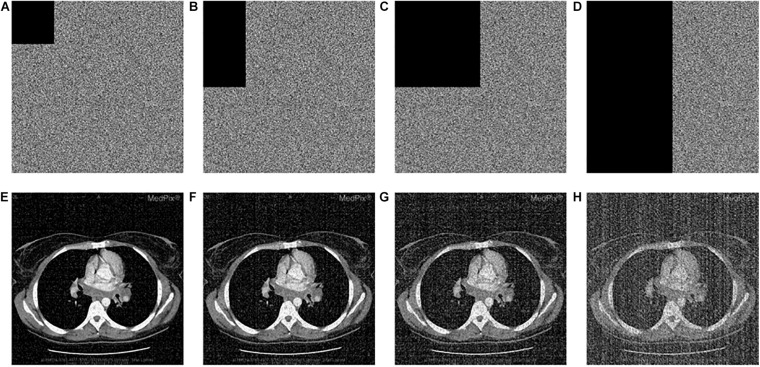
Occlusion attack: the data loss of encrypted “CT-chest” with (A) 1/16, (B) 1/8, (C) 1/4, and (D) 1/2; corresponding decrypted image (E–H) in accordance with (A–D).